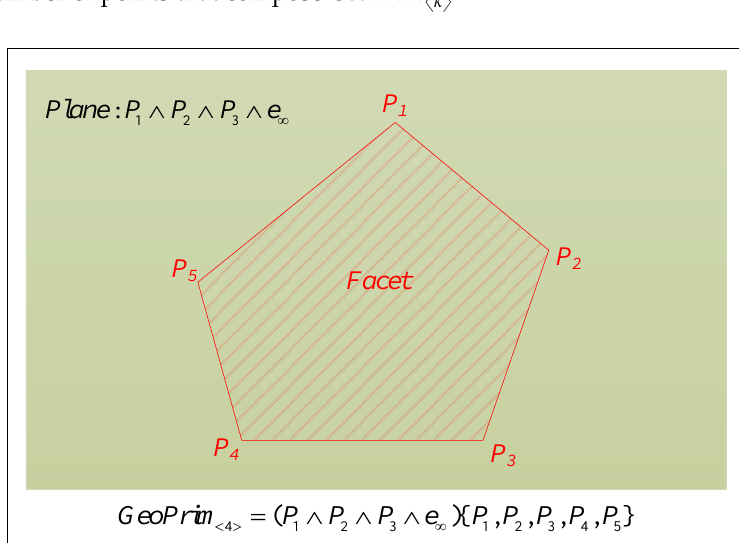
Figure 5. Primitive facet represented in 𝐶𝑙 4,1 .